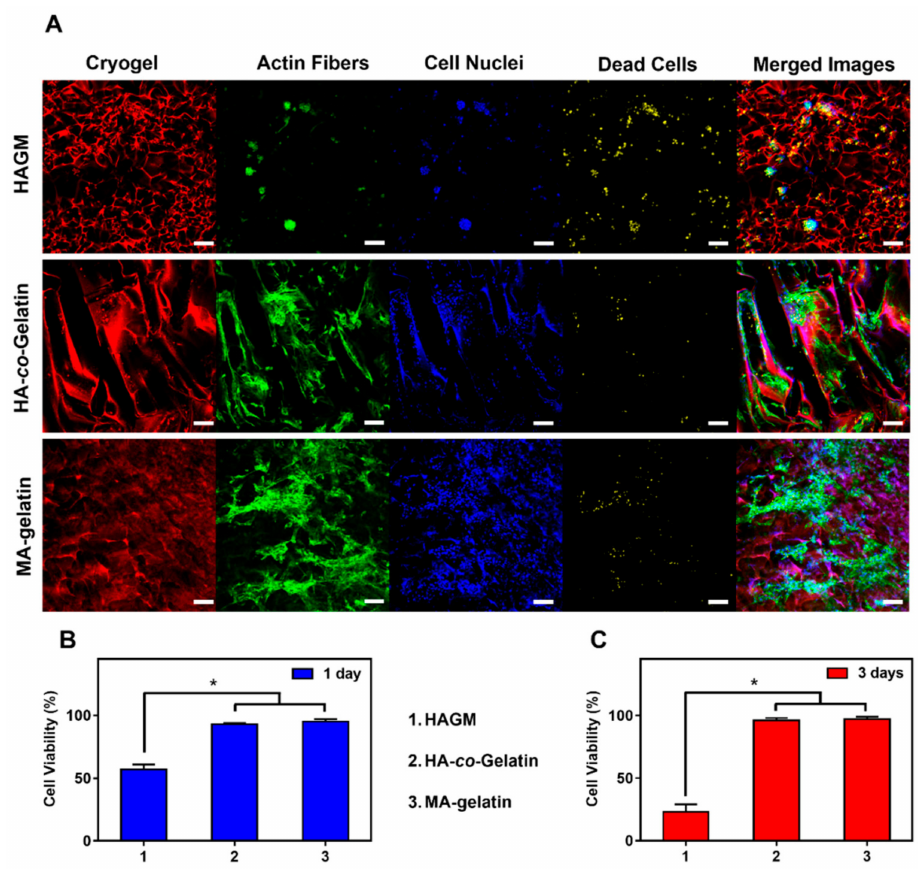
Figure 6. In vitro quantitative and qualitative evaluation of cell viability. ( A ) Confocal images of 2 × 10 5 mouse 3T3 embryonic fibroblast cells cultured for three days within HAGM, MA-gelatin, and HA- co -Gelatin cryogels. The polymer walls of cryogels are labeled with Rhodamine (red), cell nuclei with DAPI (blue), dead cells with far-red fixable dead cell staining (yellow), and cytoskeleton with Alexa Fluor 488-phalloidin (green). Viability of 3T3 embryonic fibroblast cells on the three types of cryogels after ( B ) one day and ( C ) three days’ incubation. All cryogels were fabricated at − 20 ◦ C. Values represent mean and SD ( n = 5, scale bar = 100 µ m). Viability data were analyzed using ANOVA (* p <